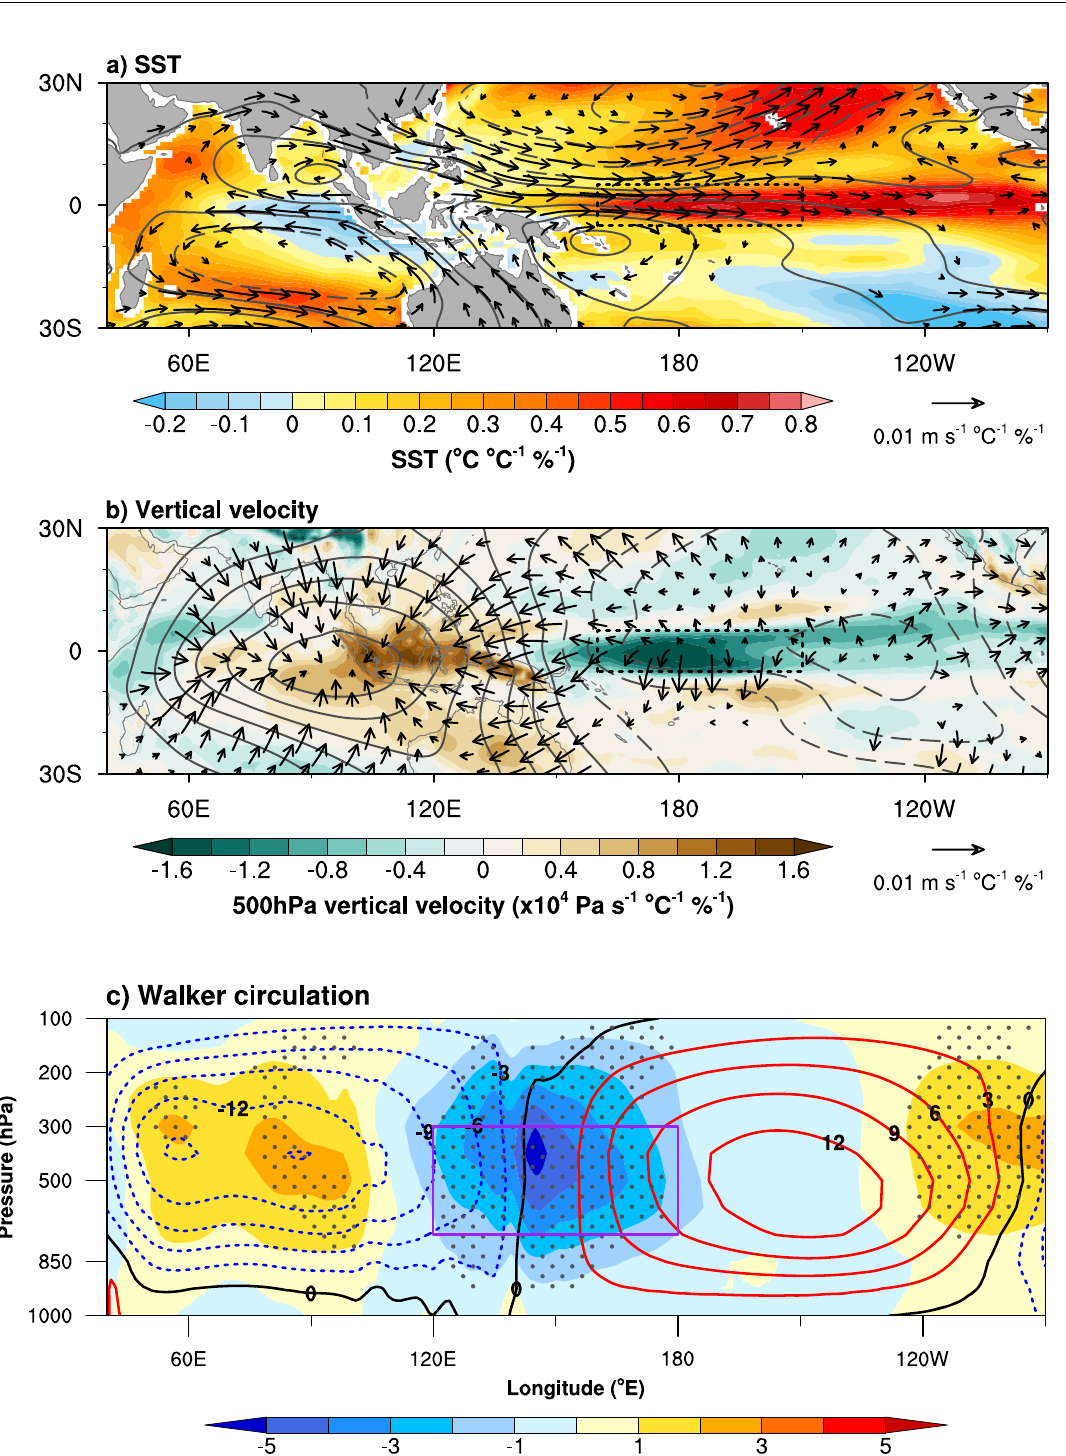
Fig. 2 Inter-model regression patterns of future changes under the SSP5-8.5 scenario onto the present-day IPWP size. a Regressed future changes in SSTs (sea surface temperature, shading: °C), 850 hPa stream function (contour interval: 0.3 × 10 3 s − 1 ), and rotational wind (vectors, m s − 1 ). b Regressed future changes in 500 hPa vertical velocity (×10 4 Pa s − 1 ; the upward motion is negative), 200 hPa velocity potential (contour interval: 0.3 × 10 3 s − 1 ), and divergent wind (vectors, m s − 1 ). c Regressed future changes in zonal stream function (shading, 10 8 kg s − 1 ) along the equator (meridional mean between 5°S and 5°N). Contours indicate MMEM of zonal stream function (10 10 kg s − 1 ) in the present-day (1950 – 1999). Stipples indicate regions of signi fi cance at the 99% con fi dence level in a student t-test. Positive values indicate a clockwise movement and negative values indicate the reverse; the resulting zero line is the center of the strongest upward motion. The purple box is the region used to de fi ne the strength of Walker circulation.